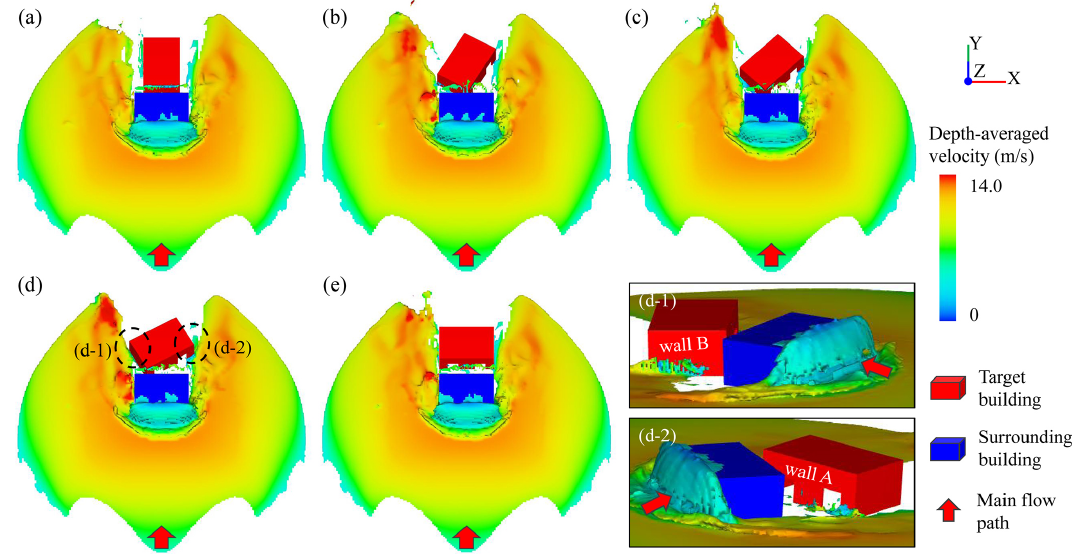
Figure 19. Snapshots for debris flow intensities in scenarios of Orx-Op0.4- A 0- D 5 at a simulation time of 8.0s. Panel (a) is the case of Or0-Op0.4- A 0- D 5, (b) is the case of Or30-Op0.4- A 0- D 5, (c) is the case of Or45-Op0.4- A 0- D 5, (d) is the case of Or60-Op0.4- A 0- D 5 and (e) is the case of Or90-Op0.4- A 0- D 5. Panels (d-1) and (d-2) show in detail that the protruding portions of the target building are exposed to debris flow.